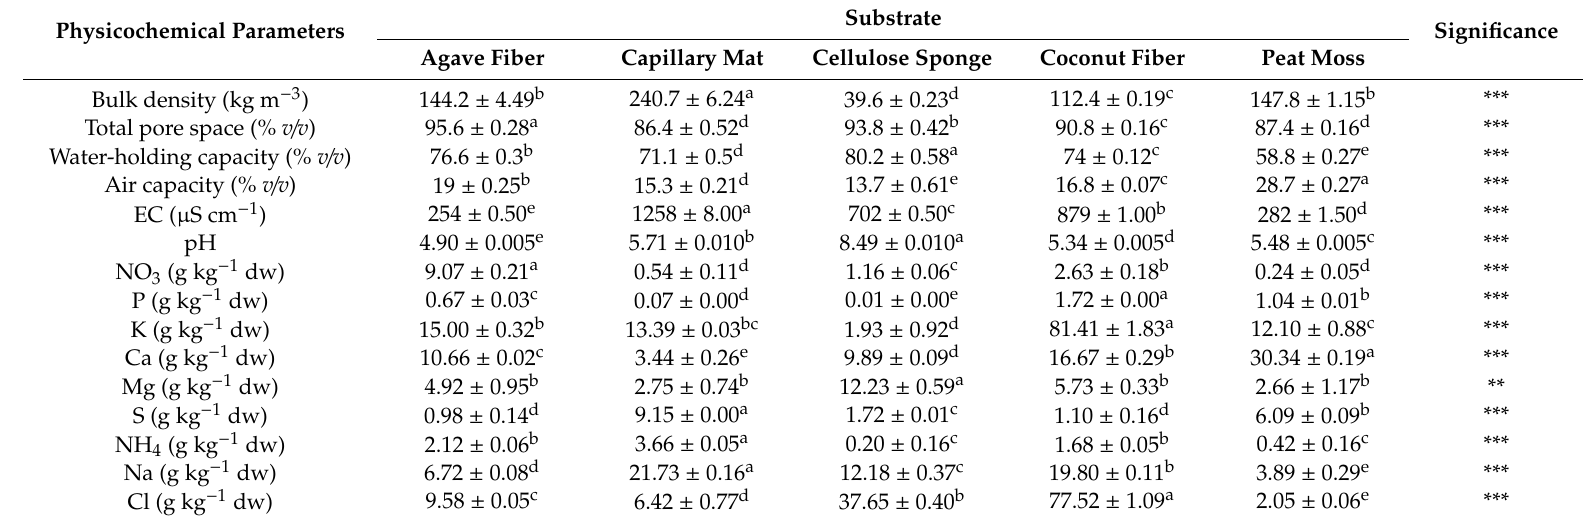
Table 1. Physicochemical characterization of natural fiber and synthetic substrates used for coriander, kohlrabi and pak choi microgreens production in a controlled environment. All data are expressed as mean ± standard error, n =